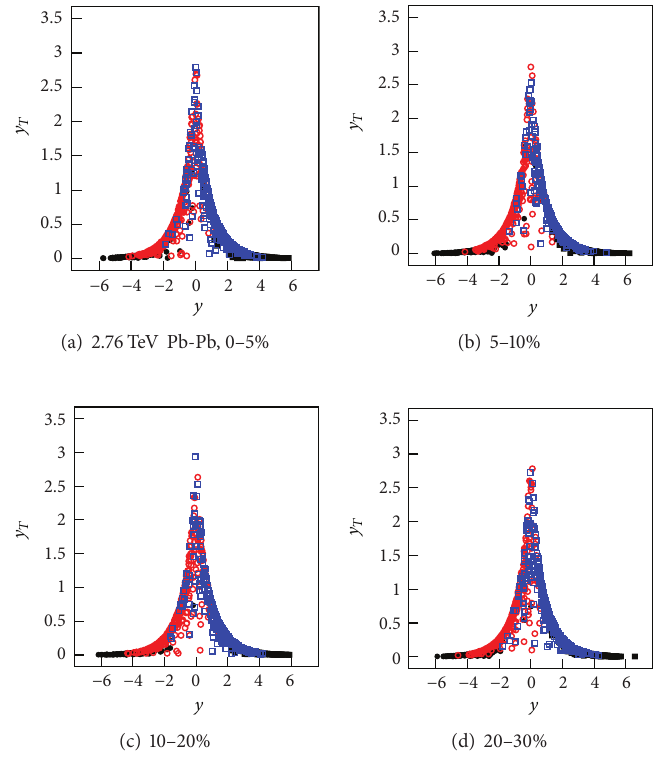
Figure 11: The same as for Figure 4, but showing the results in the space 𝑦 𝑇 − 𝑦 .